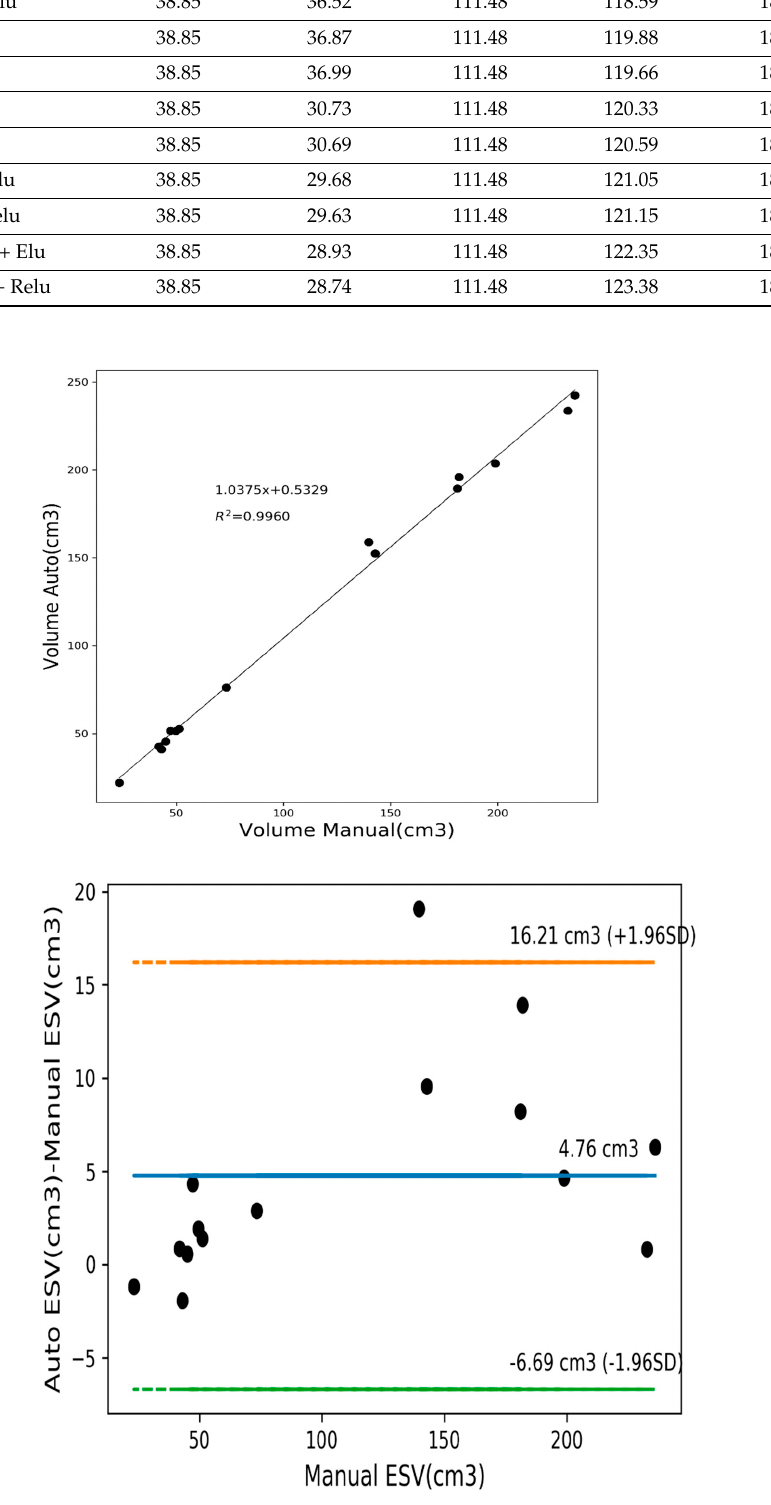
Figure 22. Linear regression plot (Top) and Bland–Altman plot (Bottom) for ESV.